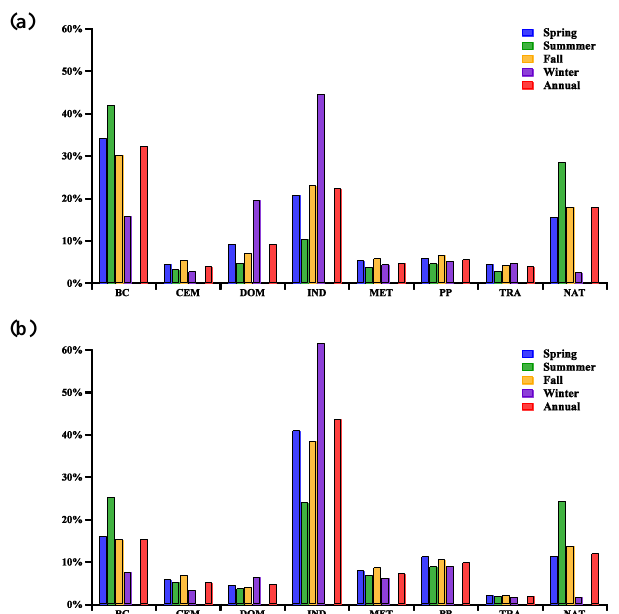
Figure 5. Source contributions to seasonal and annual mercury (a) wet and (b) dry